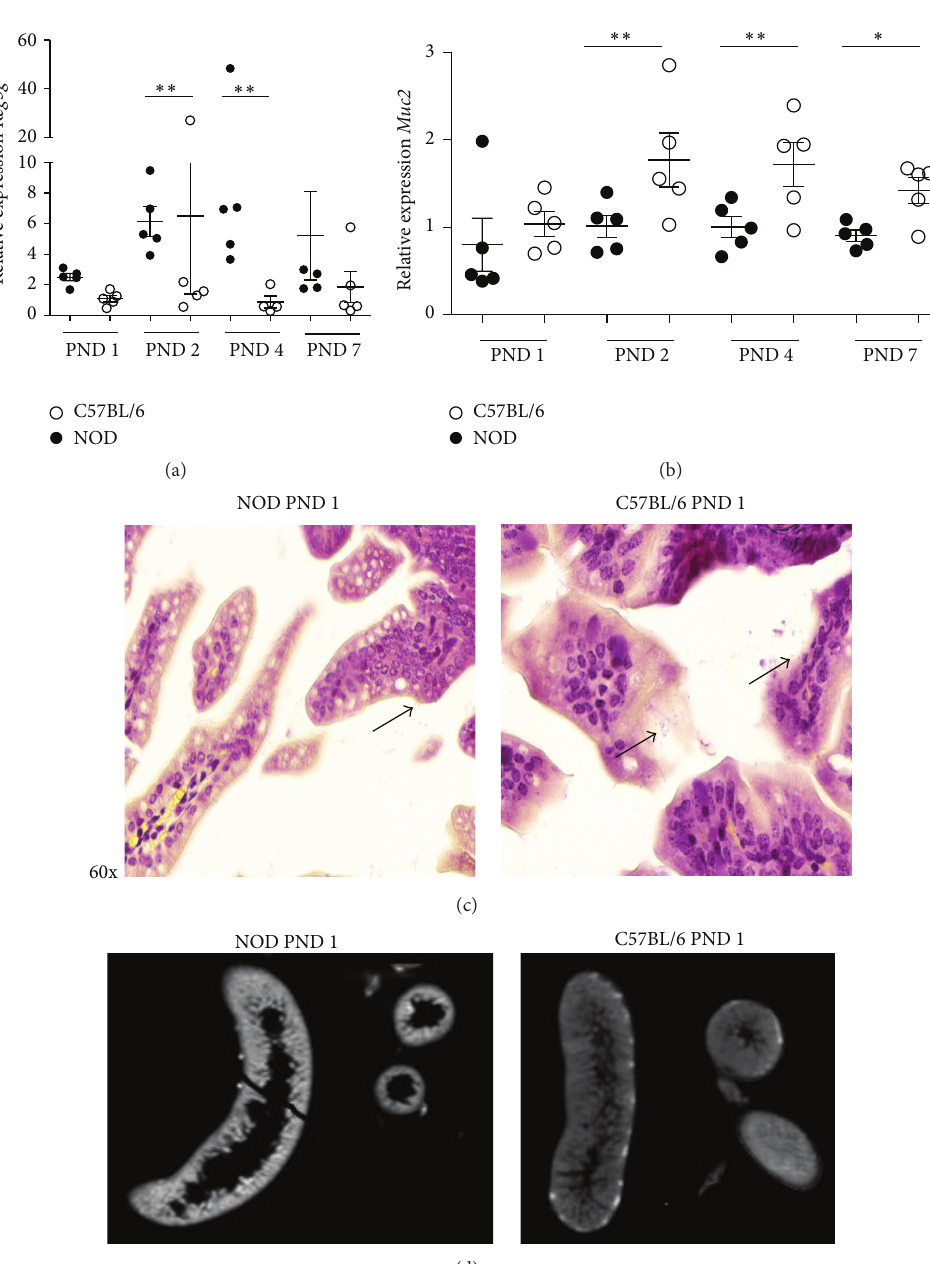
Figure 8: Relative gene expression of RegIII 𝛾 analyzed in intestine tissue from NOD and C57BL/6 mice correlates with Gram-stain sections of the same intestines and OPT scanning. Data were normalized to Actb and then to C57BL/6 PND 1, which were defined as value 1. All groups were included in a 2-way ANOVA. ∗∗ 𝑝 < 0.05 . (a) Relative gene expression of Reg3g , analyzed in intestine tissue from NOD and C57BL/6. (b) Relative gene expression of muc2 in intestinal tissue from NOD and C57BL/6. (c) Gram-stain sections of intestine 60x magnification. Arrows indicate presence of bacteria. In sections of NOD intestine (left side) bacteria were present in the lumen but very few and mostly Gram- positive bacteria were attaching to the villi. In contrast a larger amount of both Gram-negative and Gram-positive bacteria was attaching to the surface of the villi in the intestine of C57BL/6 mice. (d) PND 1 mouse intestine autofluorescence image acquired with the OPT system. Digital sections of the PND 1 intestine illustrated in gray-scale demonstrating autofluorescence anatomy data in NOD and C57BL/6. Intestinal sections from C57BL/6 mice displayed more dens villi compared to NOD